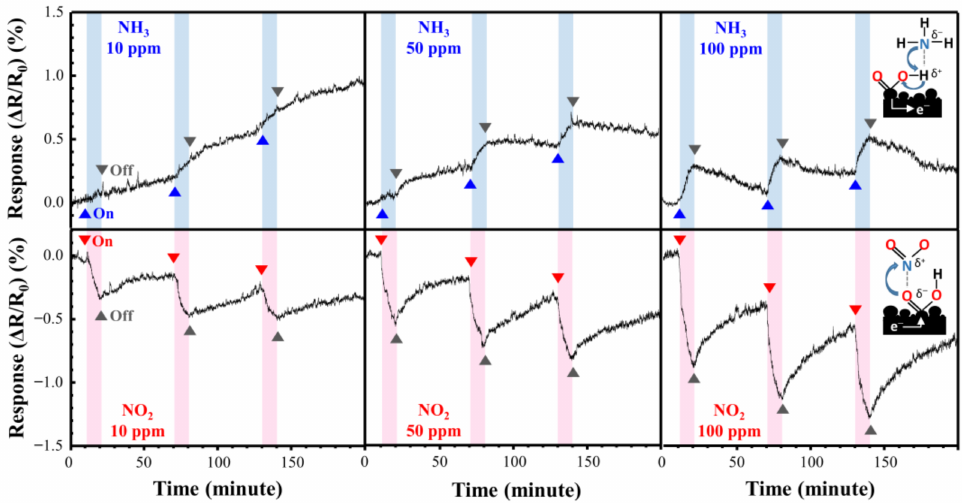
Figure 9. Response curves of Cu@LSC with NO 2 and NH 3 exposure.